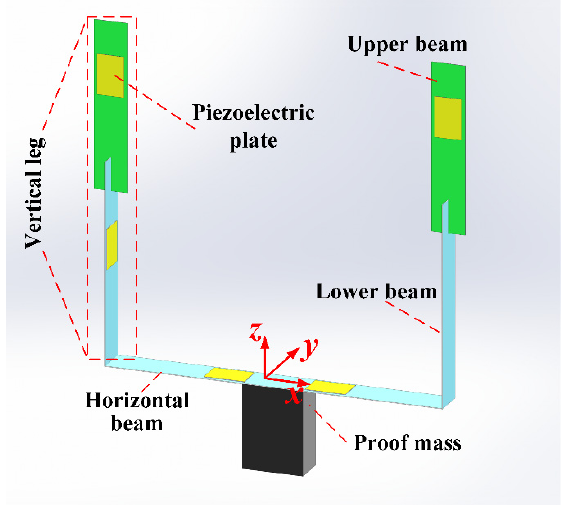
Figure 1. The proposed U-shaped structure with cross-connected beams.